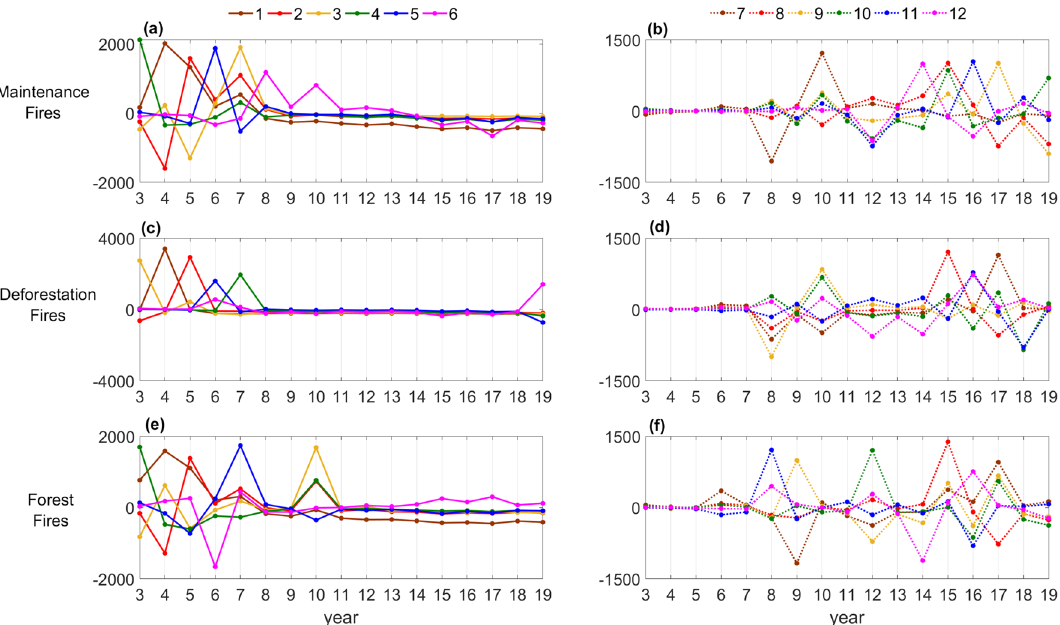
Figure 6. Time series of PCs 1–6 for ( a ) maintenance, ( c ) deforestation, and ( e ) forest fires, and of PCs 7–12 for ( b ) maintenance, ( d ) deforestation, and ( f ) forest fires for the 2003–2019